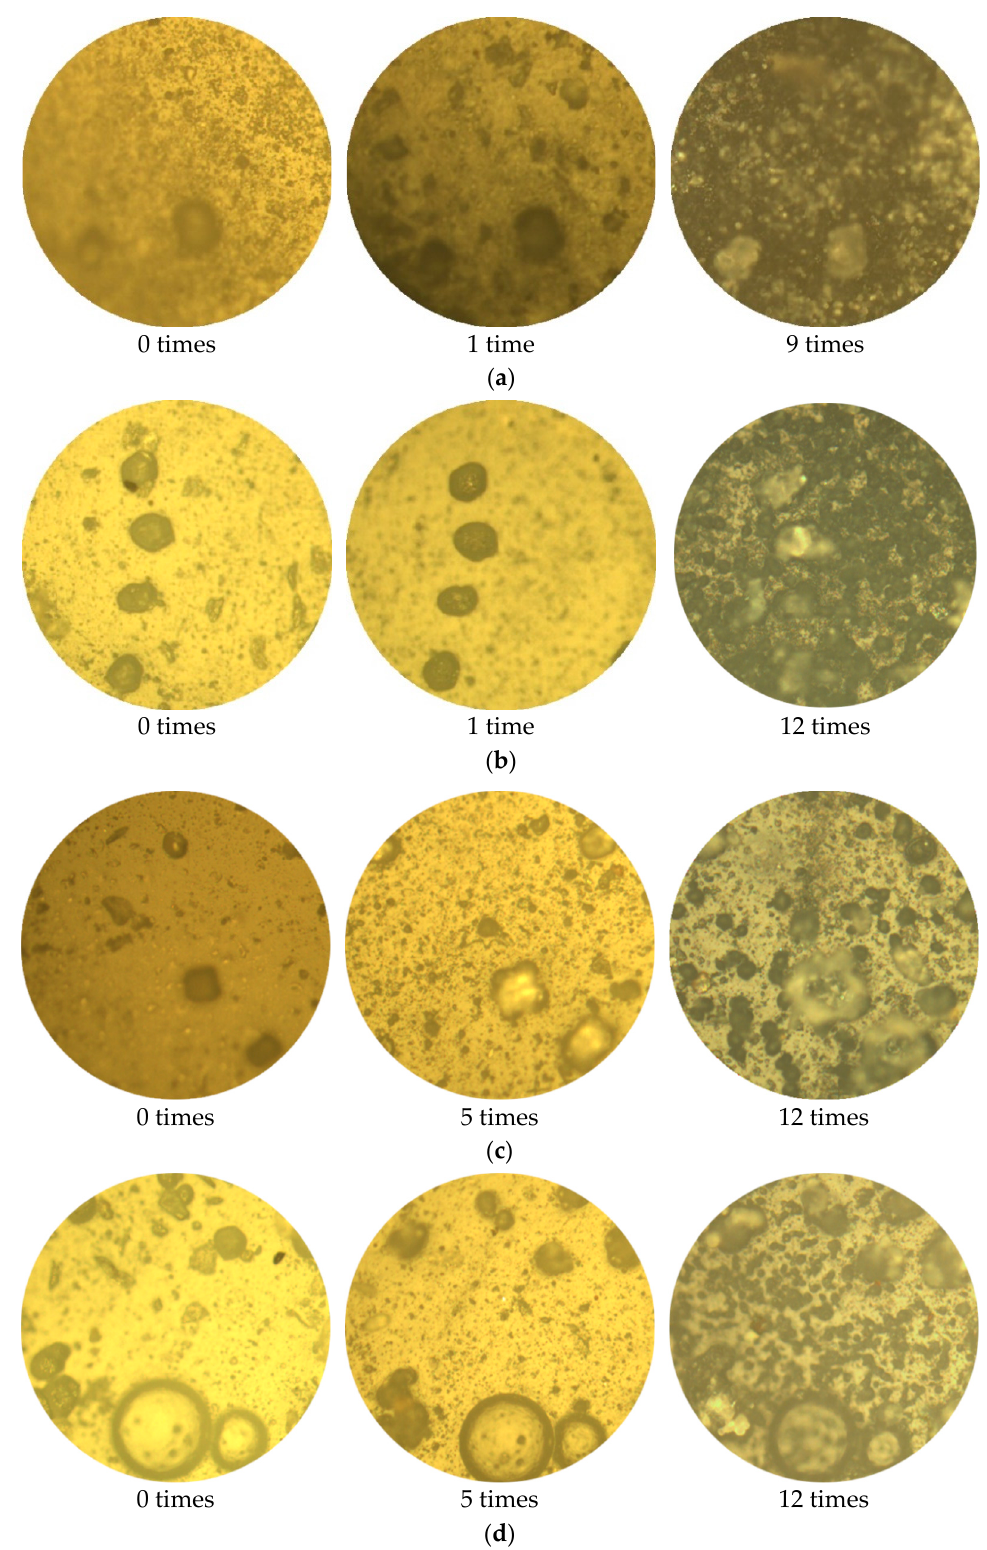
Figure 6. Surface morphology of the W-OH solid consolidation after dry–wet cycles: ( a ) W-OH con-